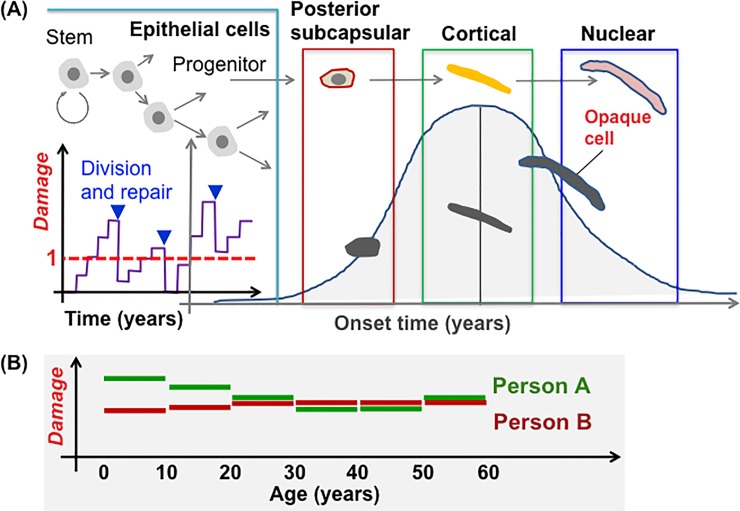
A schematic diagram outlining a model for spontaneous cataractogenesis.(A) Modeling of processes leading to manifestations of cataract predicated on the level of Damage that accumulates in lens epithelial cells. On one hand, upon cell division, the level of Damage decreases due to repair. On the other hand, when the level of Damage continues to exceed 1, posterior subcapsular or cortical cataracts appear at the onset time assigned to individual cells. (B) Lifelong assignment of Damage. Damage is randomly assigned to each individual person for every decade of life. The panel exemplifies two persons assigned with different levels of Damage as a function of age in years.